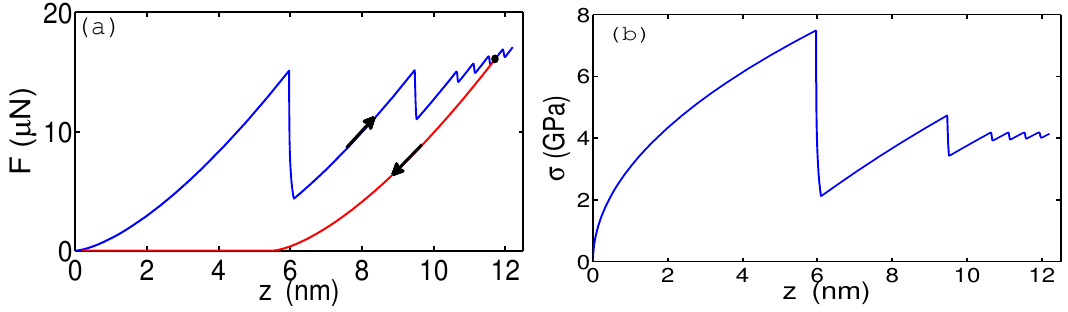
Figure 4. ( a ) Plots of load as a function of z for the loading (blue) and unloading (red) runs; ( b ) corresponding plot of stress. Parameters used are given in the Table 1, after